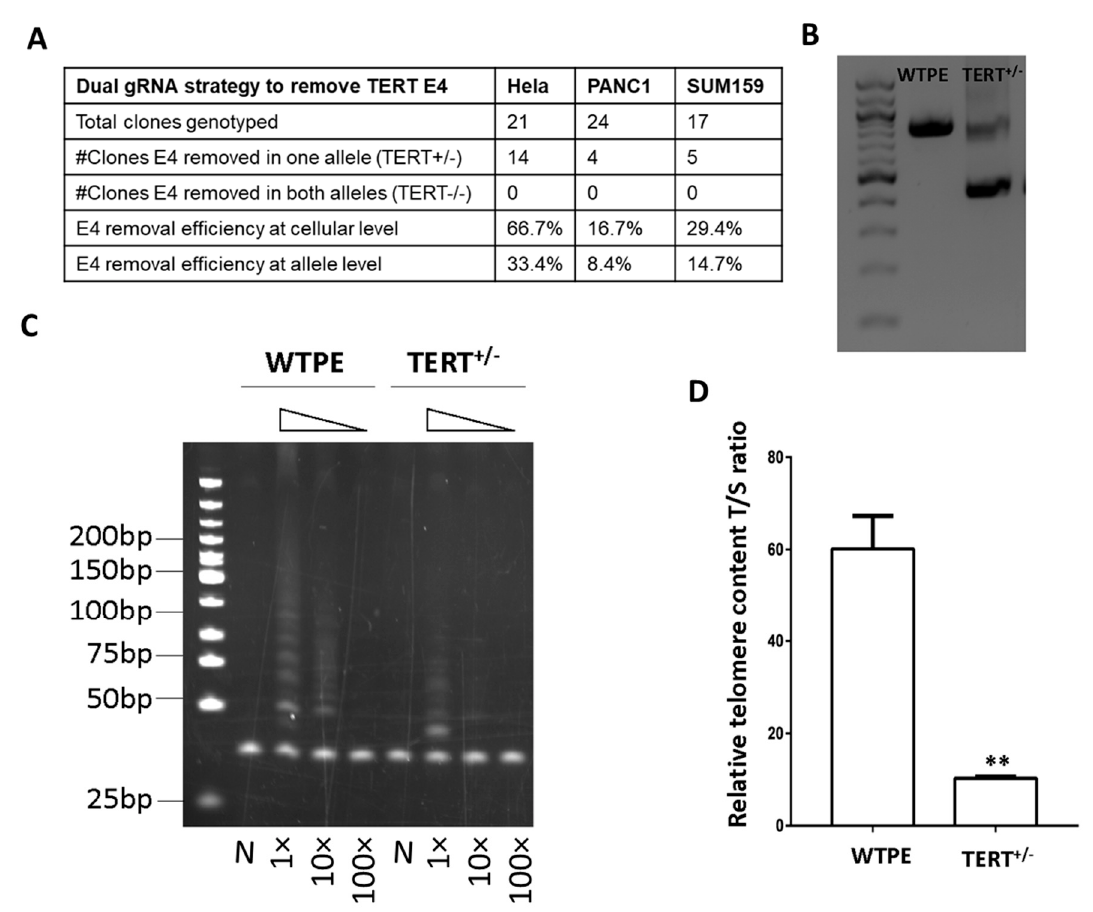
Figure 2. Generation of TERT +/ − tumor cells by the exon removal strategy using sg4 and sg5. ( A ) Efficiencies of E4 removal by using both sg4 and sg5. ( B ) Representative genotyping results of a TERT +/ − Hela cell clone. M: molecule weight markers. ( C ) Telomerase activity in WT and TERT +/ − Hela cells at 1×, 10× and 100× dilutions determined by the TRAP assay. N: heat inactivated negative control. M: molecule weight markers. ( D ) Relative telomere content T/S ratio in WT and TERT +/ − Hela cells. ** p < 0.01.